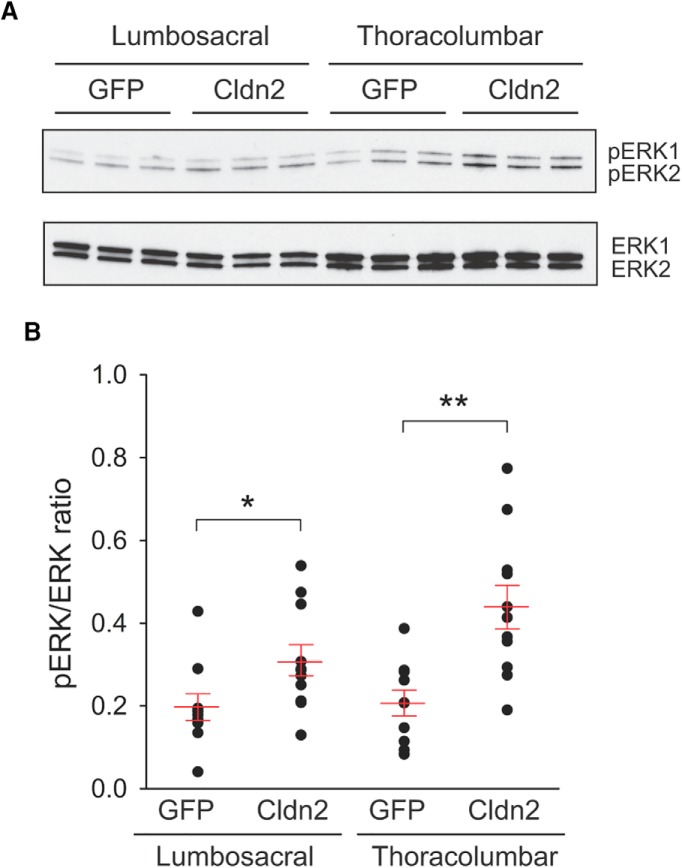
Overexpression of Cldn2 in the urothelium activates ERK in spinal cord segments receiving bladder input. A, Representative Western blotting of total (ERK) and phosphorylated (pERK) forms of ERK1/2 in spinal cord segments receiving pelvic (LS) and hypogastric (TL) nerve afferents from rats transduced with AdGFP or AdCldn2. B, Analysis of pERK/ERK ratio in LS and TL segments of rats transduced with AdGFP or AdCldn2. Statistically significant differences between experimental conditions are indicated as *p < 0.05 and **p < 0.01 (n = 10–11, Mann-Whitney nonparametric test).